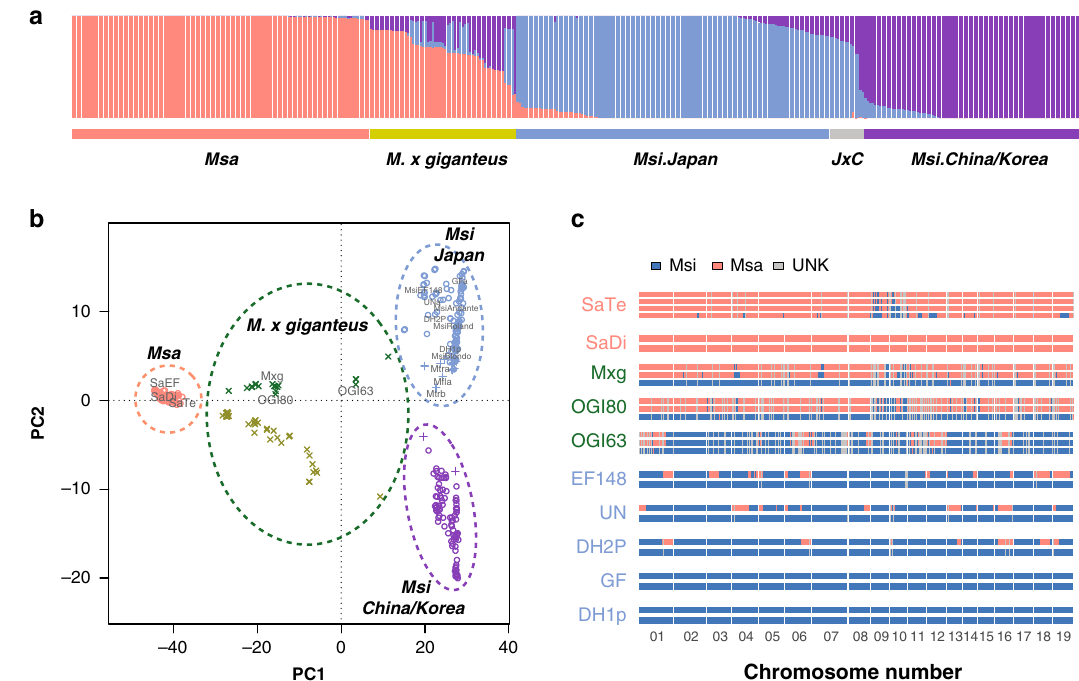
Fig. 5 Miscanthus population structure and segmental ancestry. a Population structure of 407 miscanthus accessions, including 57 M . × giganteus , 120 M. sacchari fl orus ( Msa ), and M. sinensis ( Msi ) from China (75), Korea (15), and Japan (140). b Principal component analysis of 407 miscanthus accessions where “ x ” marks admixtures of Msa and Msi . Such hybrids are collectively referred to as M . × giganteus (Mxg), and can be diploid, triploid, or tetraploid. Separation of Japanese and mainland Asian populations is largely consistent with structure analysis in a . Whole-genome shotgun (WGS)-sequenced accessions are labeled. c Segmental ancestry of miscanthus accessions based on WGS sequencing. Each horizontal bar denotes one (imputed) haploid chromosome set; red and blue indicate Msa and Msi ancestry, respectively. The number of bars represents ploidy. Introgression of M. sacchari fl orus into M. sinensis (MsiEF148, Undine, DH2, DH2P) is common among cultivated European types (Supplementary Fig. 10). Source Data underlying Fig. 5c are provided as a Source Data fi